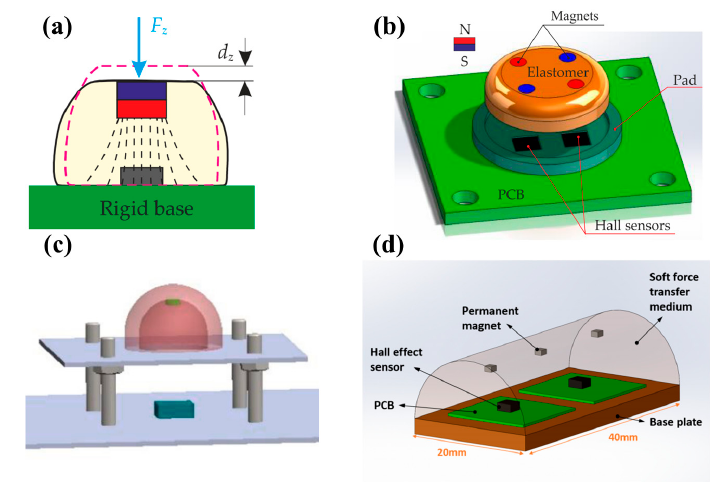
Figure 10. All kinds of shapes of convex structures used in magnetic tactile sensors. (a) Magnetic tactile sensor with a convex structure (designed by Hongbo Wang). Reprinted with permission from Ref. [42]. Copyright 2016, MDPI. (b) Magnetic tactile sensor with a convex structure (designed by Hongbo Wang). Reprinted with permission from Ref. [43]. Copyright 2016, Elsevier. (c) Magnetic tactile sensor with a convex structure (designed by Ping Yu). Reprinted with permission from Ref. [53]. Copyright 2014, Springer Nature. (d) Magnetic tactile sensor with a convex structure (designed by Alireza Mohammadi). Reprinted with permission from Ref. [81]. Copyright 2019, MDPI.